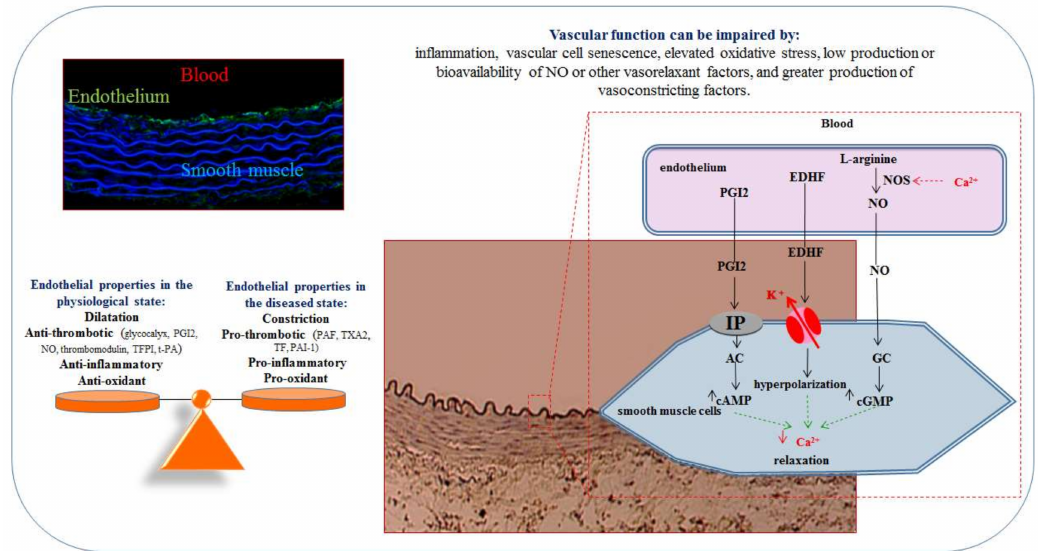
Figure 1. The endothelium influences the blood vessel’s health. PGI2, prostacyclin; TXA2, throm- boxane A2; EDHF, endothelium-derived hyperpolarizing factor; NO, nitric oxide; NOS, nitric oxide synthase; IP, prostacyclin receptor; AC, adenylate cyclase; GC, guanylate cyclase; cAMP, cyclic adenosine monophosphate; cGMP, cyclic guanosine monophosphate; TFPI, tissue factor pathway inhibitor; t-PA, tissue plasminogen activator; PAF, platelet-activating factor; TF, tissue factor; PAI-1, plasminogen activator